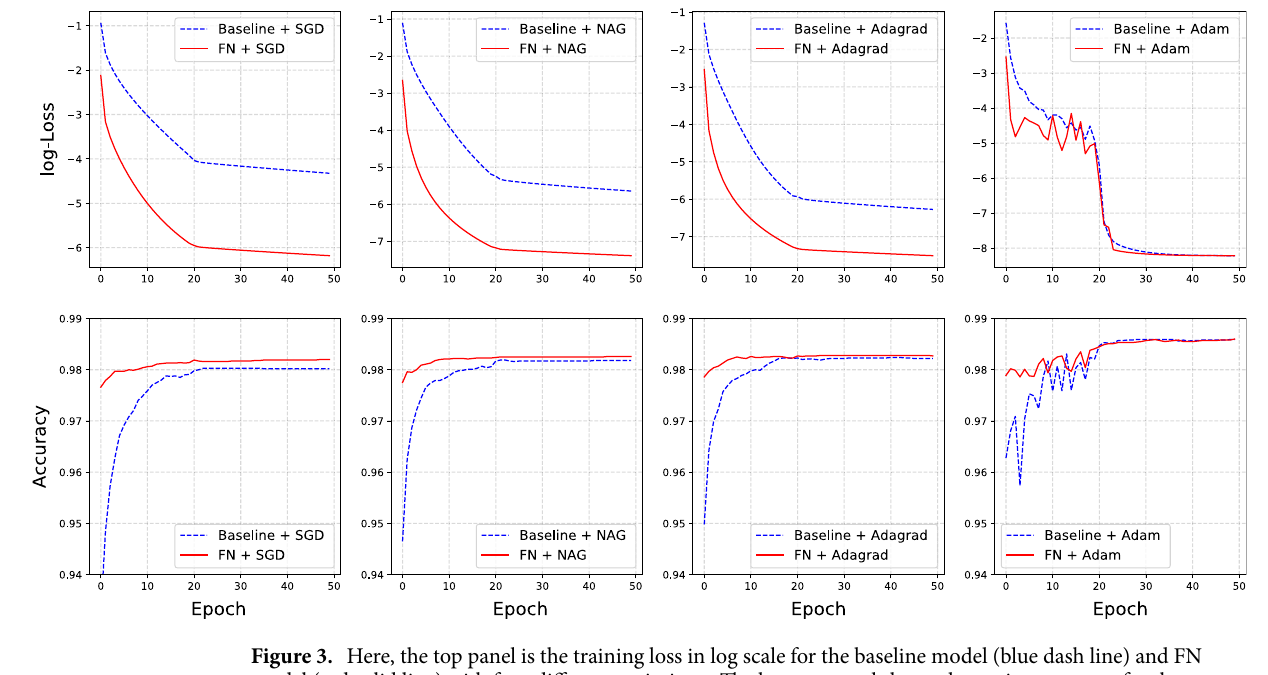
Figure 3. Here, the top panel is the training loss in log scale for the baseline model (blue dash line) and FN model (red solid line) with four different optimizers. The bottom panel shows the testing accuracy for the baseline model (blue dashed line) and the FN model (red solid line) with different optimizers.